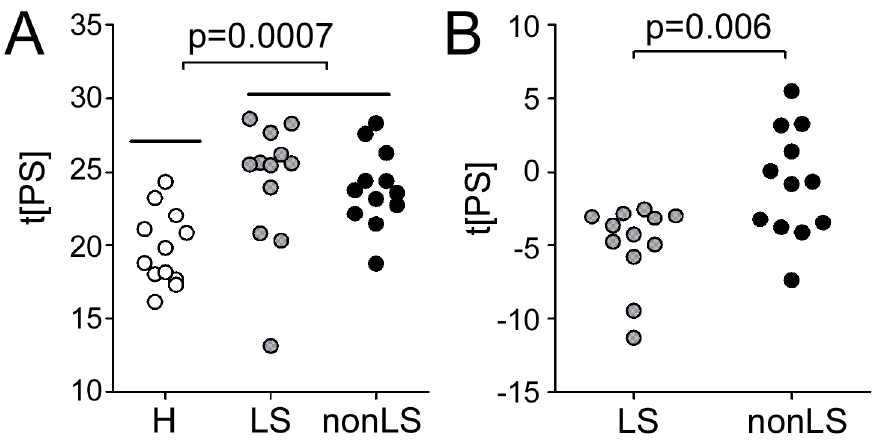
Figure 6. Predictive scores of the serum profiles. Predictive scores of the serum profiles using ( A ) information obtained from the OPLS-DA models of BALF-controls vs. BALF-sarcoidosis and ( B ) information obtained from BALF-LS vs. BALF-nonLS phenotypes.